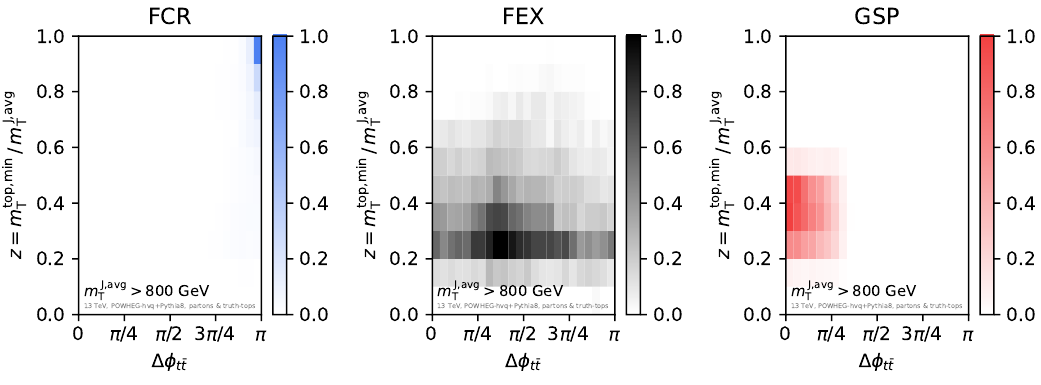
, in each of the Figure 3 . Kinematic distribution of the softer top, for events with large m J, avg T three main topologies. The plots show dσ/dzd ∆ φ , normalised to 1 at the maximum value of the t ¯ t histogram; z = m top,min measures the hardness of the softer top relative to the underlying /m J, avg T T 2 → 2 event hardness, and ∆ φ is the azimuthal distance between the two top quarks. t ¯ t